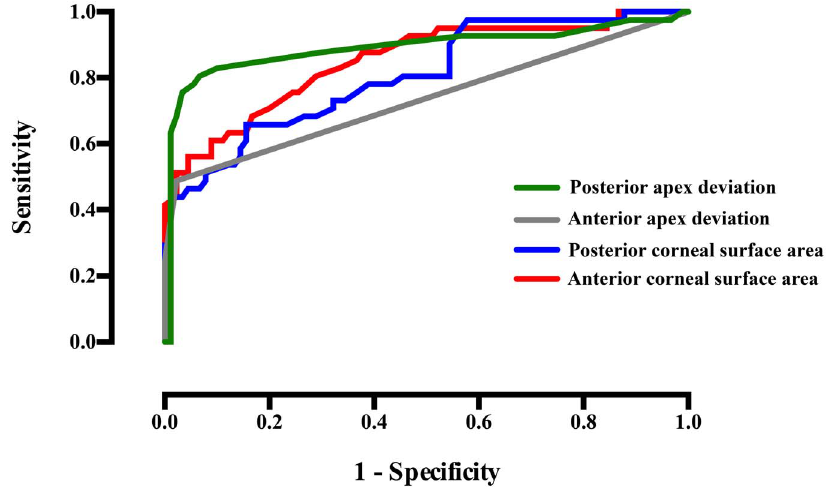
Figure 7. ROC curve modeling the sensitivity versus 1-specificity for variables diagnosing the existence of keratoconus disease (plotted only selected variables with area under the curve over 0.7).